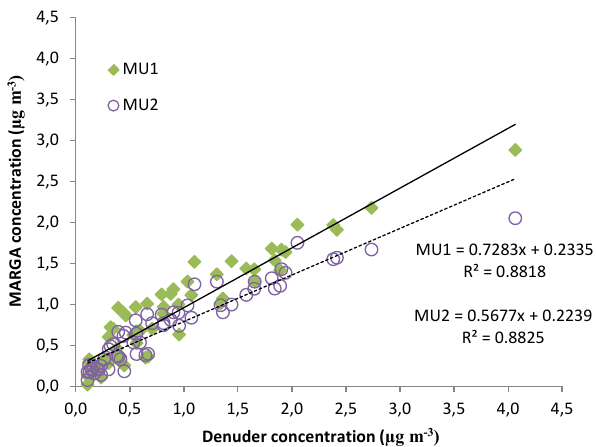
Figure 12. Regression analysis of MARGA HNO 3 concentrations Fig. 12. Regression analysis of MARGA HNO 3 concentrations against denuder HNO 3 3 against denuder HNO 3 concentrations. 4